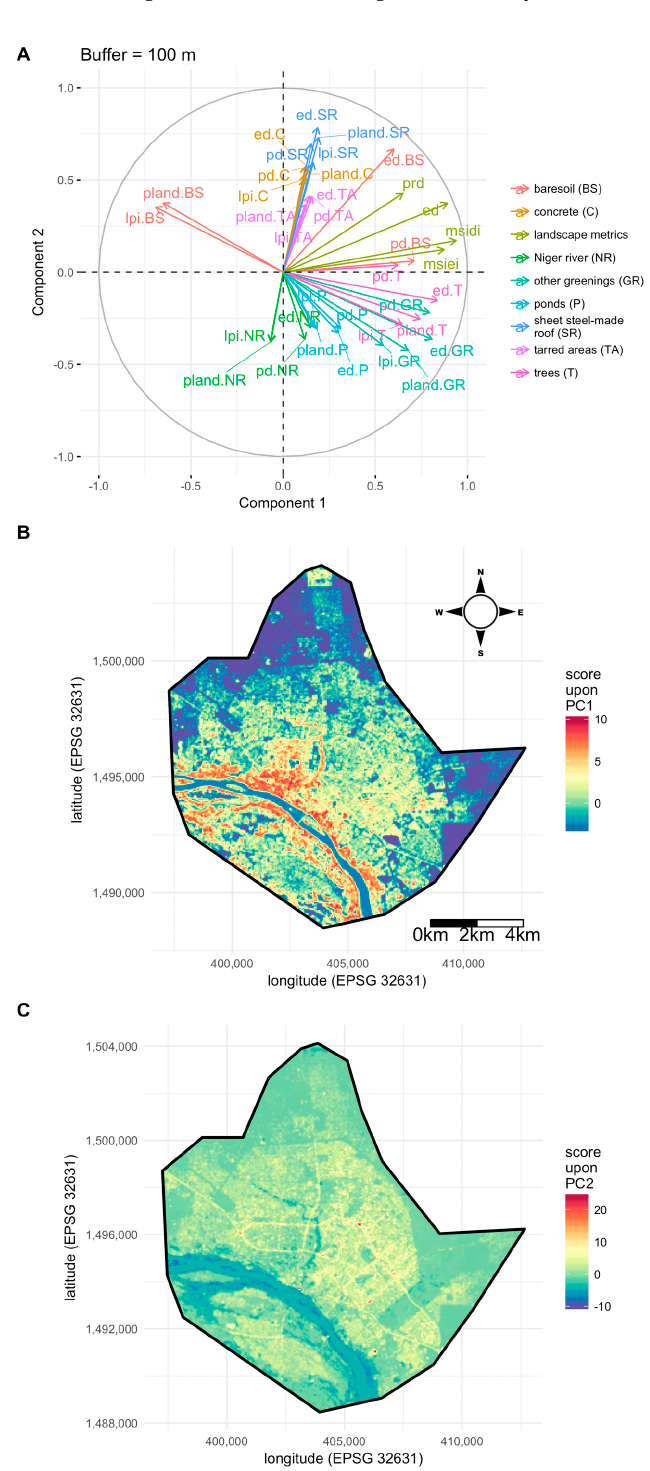
Figure 3. PCA of landscape metrics describing the urban landscape of the city of Niamey (Niger): ( A ) correlation circle; ( B ) map of the first PCA axis; ( C ) map of the second PCA